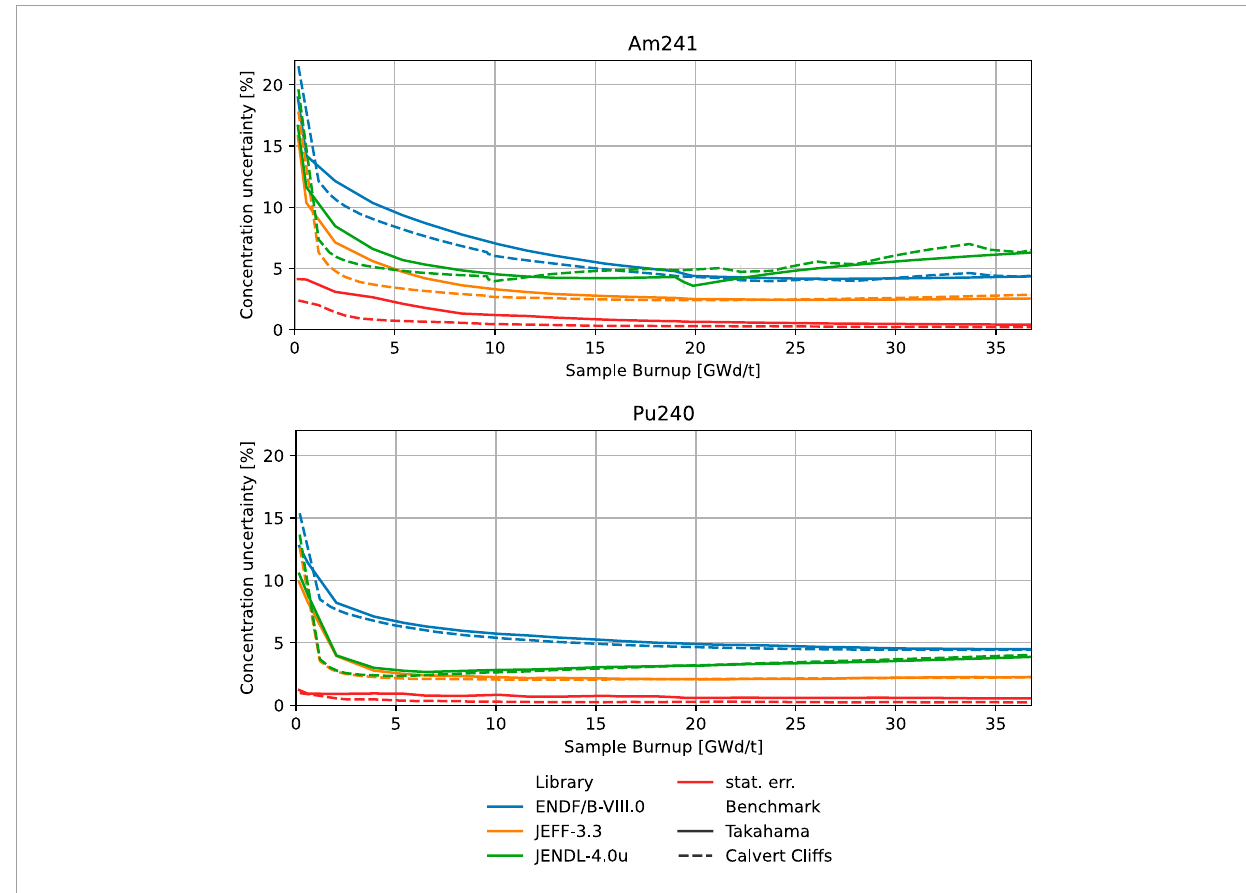
FIGURE 8 Concentration uncertainty evolution with burnup for nuclides 241 Am (top) and 240 Pu